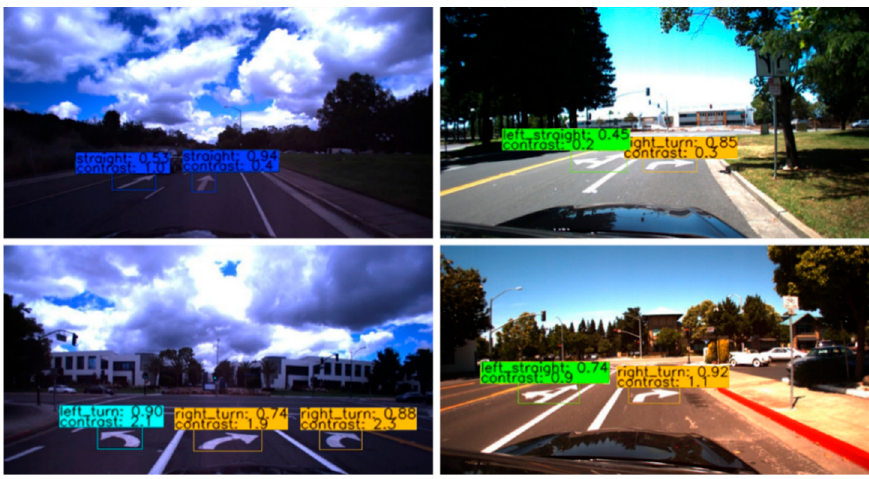
Figure 11. Visual results were evaluated on the testing samples.